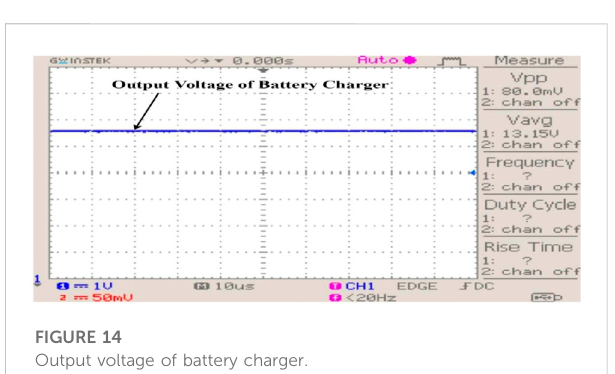
FIGURE 14 Output voltage of battery